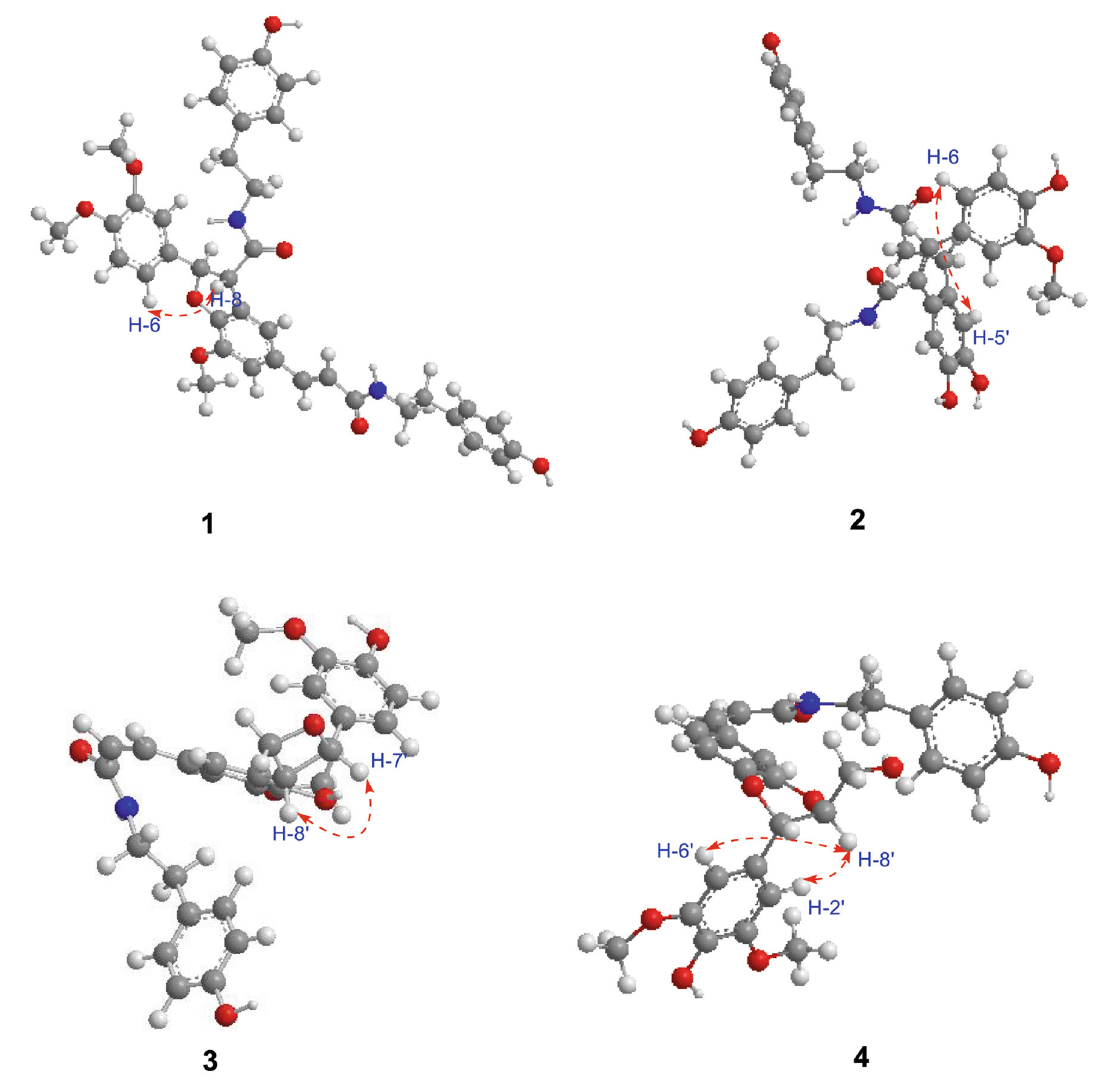
Fig. 3 Key ROESY ( ) correlations of compounds 1 –